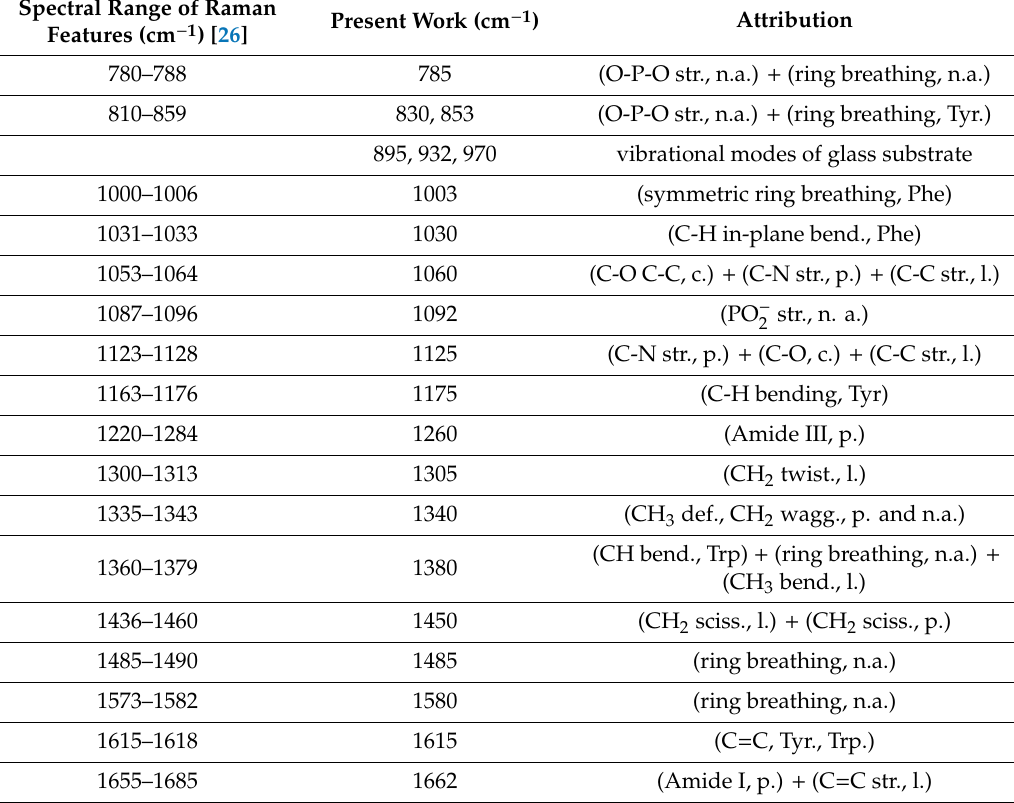
Table 1. Attribution of Raman spectral features, according to the literature [26] and present work